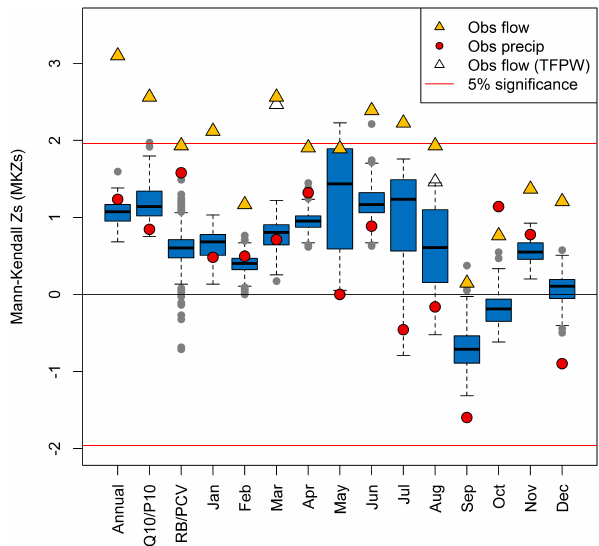
Figure 8. Mann–Kendall tests for monotonic trend in precipitation and flow indicators. MKZs values above (below) 5% significance line ( | MKZs | > 1.96) indicate significant increasing (decreasing) trends. Boxplots summarise MKZs values for 328 reconstructed time series, with the black line representing the median, and boxes the interquartile range (IQR); whiskers extend to the most extreme data point, which is no more than 1.5 times the IQR from the box, and grey circles are outliers beyond this